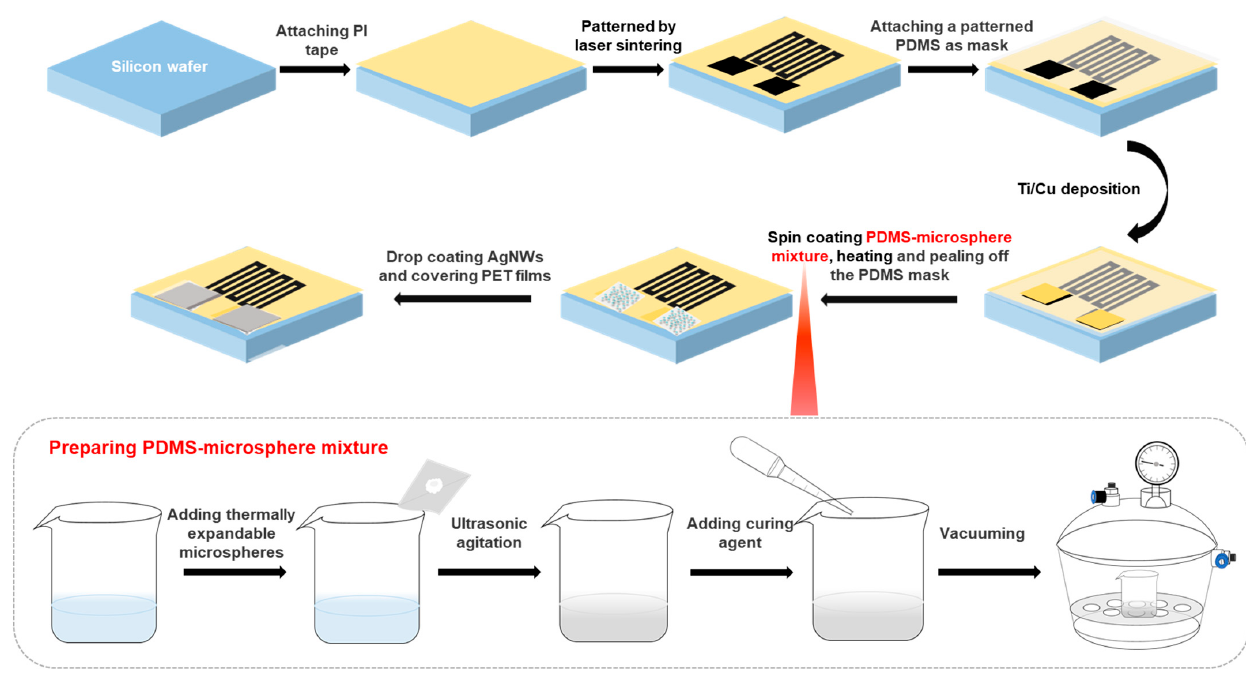
Figure 2. Schematic diagram of the fabrication process of the integrated system. The part in the grey dotted box at the bottom is the preparation process of the PDMS ‐ microsphere mixture.